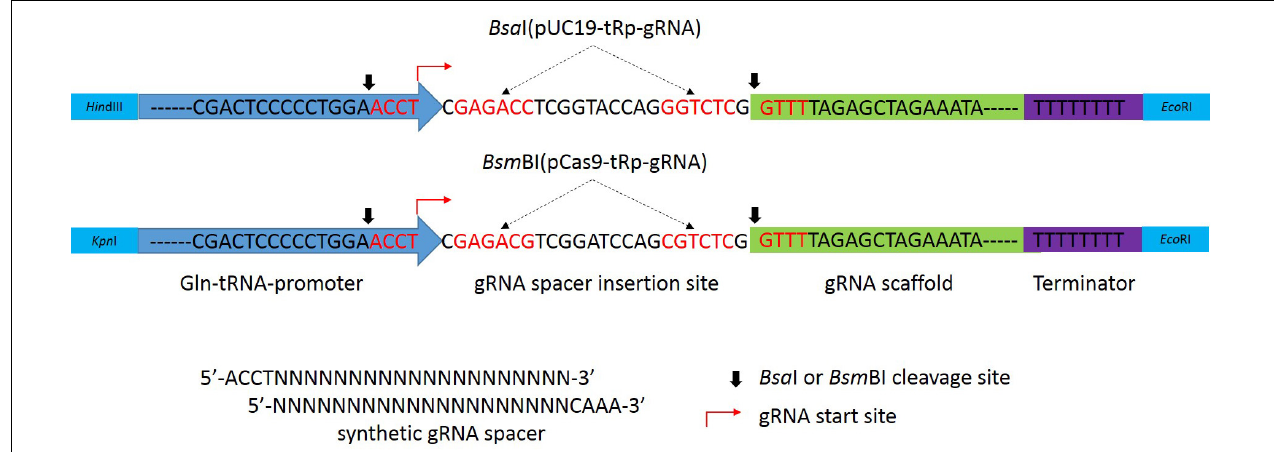
FIGURE 1 | Diagram of the modified Gln-tRNA-gRNA cassettes in pUC19-tRp-gRNA and pCas9-tRp-gRNA vectors. The blue arrow on the left is the Gln-tRNA promoter that is followed by the gRNA spacer insert site, gRNA scaffold (green), and RNA polyIII terminator (purple) sequences. The gRNA spacers are synthesized by annealing the sense and antisense oligonucleotides with 5 (cid:48) -ACCT and 3 (cid:48) -CAAA overhangs and inserted into the gRNA spacer insertion site of Bsa I-digested pUC19-tRp-gRNA (upper) or Bsm BI-digested pCas9-tRp-gRNA (lower). The gRNA start site is marked with a red arrow. The cleavage sites of type II restriction enzyme Bsa I and Bsm BI are marked with black